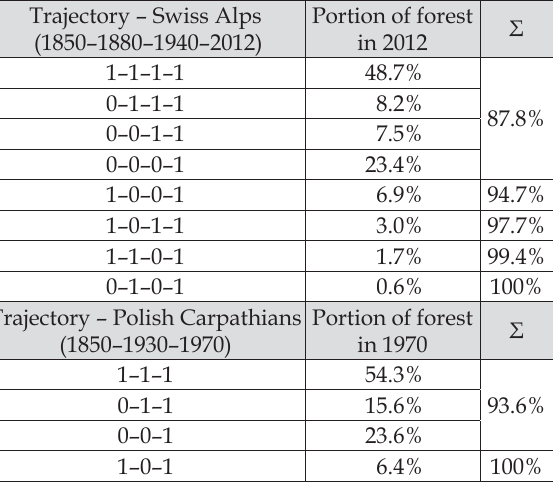
Table 2. Trajectory analysis for Swiss and Polish parts of the study area (1 – forest, 0 – non-forest) Trajectory – Swiss Alps